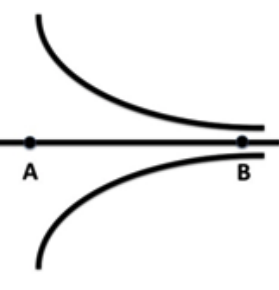
Figure 1. The cognitive span required during diagnosis.